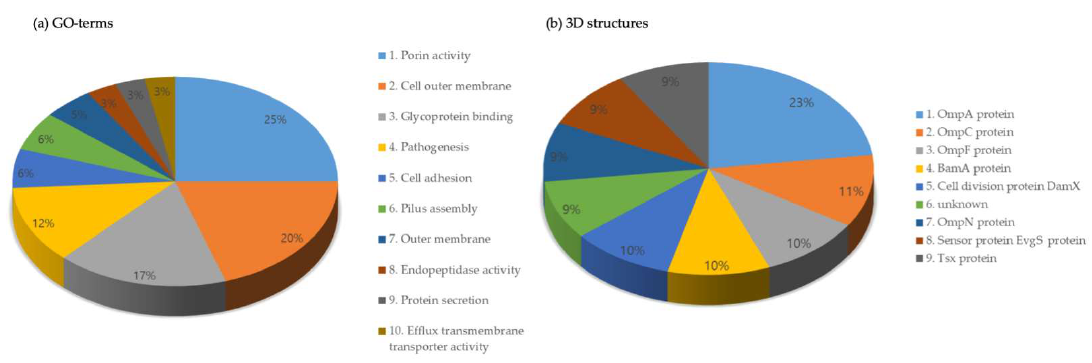
Figure 2. The ten most abundant proteins according to the Gene Ontology (GO) terms and 3D structures. ( a ) GO terms associated with outer-membrane-embedded proteins. ( b ) 3D structures of the outer-membrane-embedded